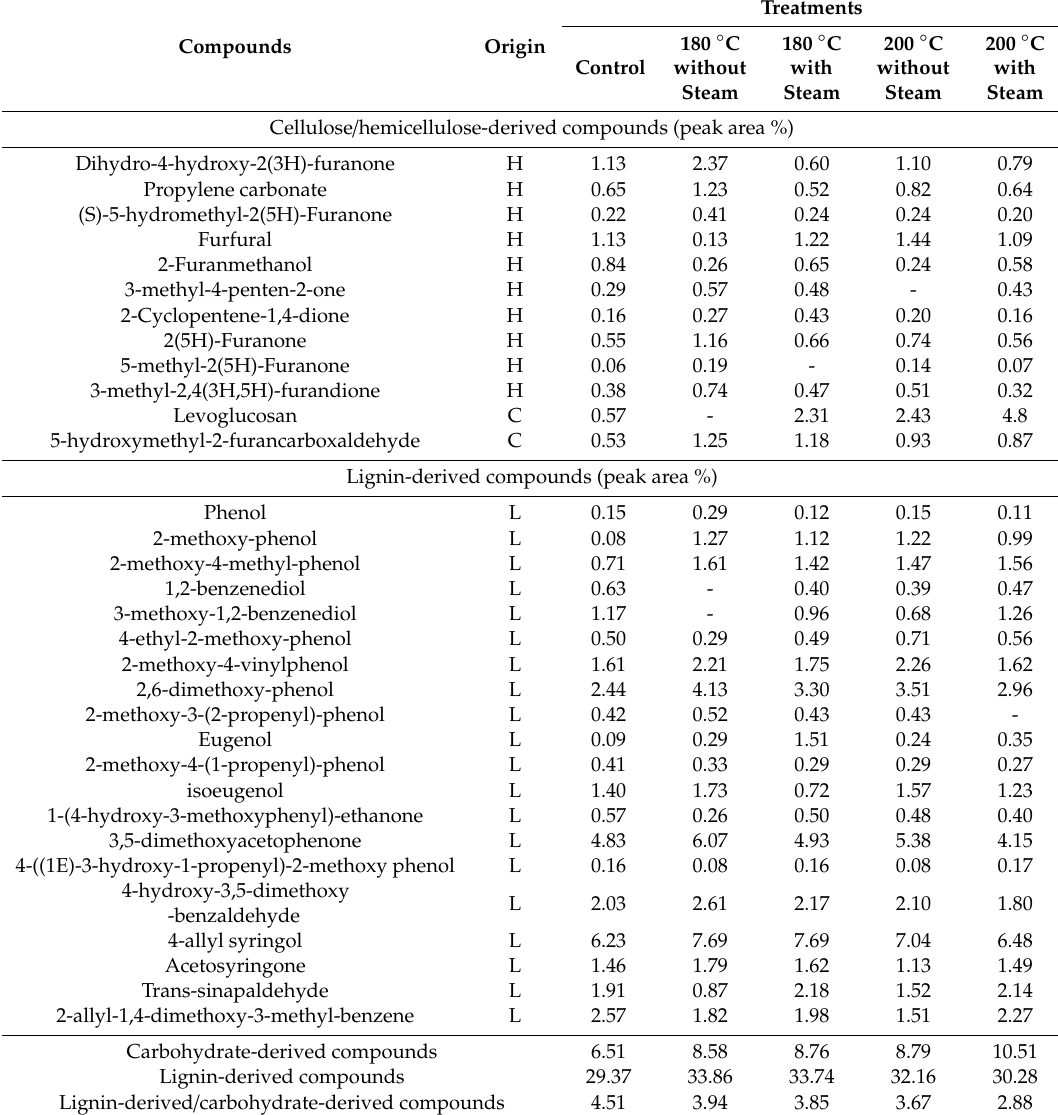
Table 3. Percentages of lignin and carbohydrate-related products released from the control and densified sugar maple